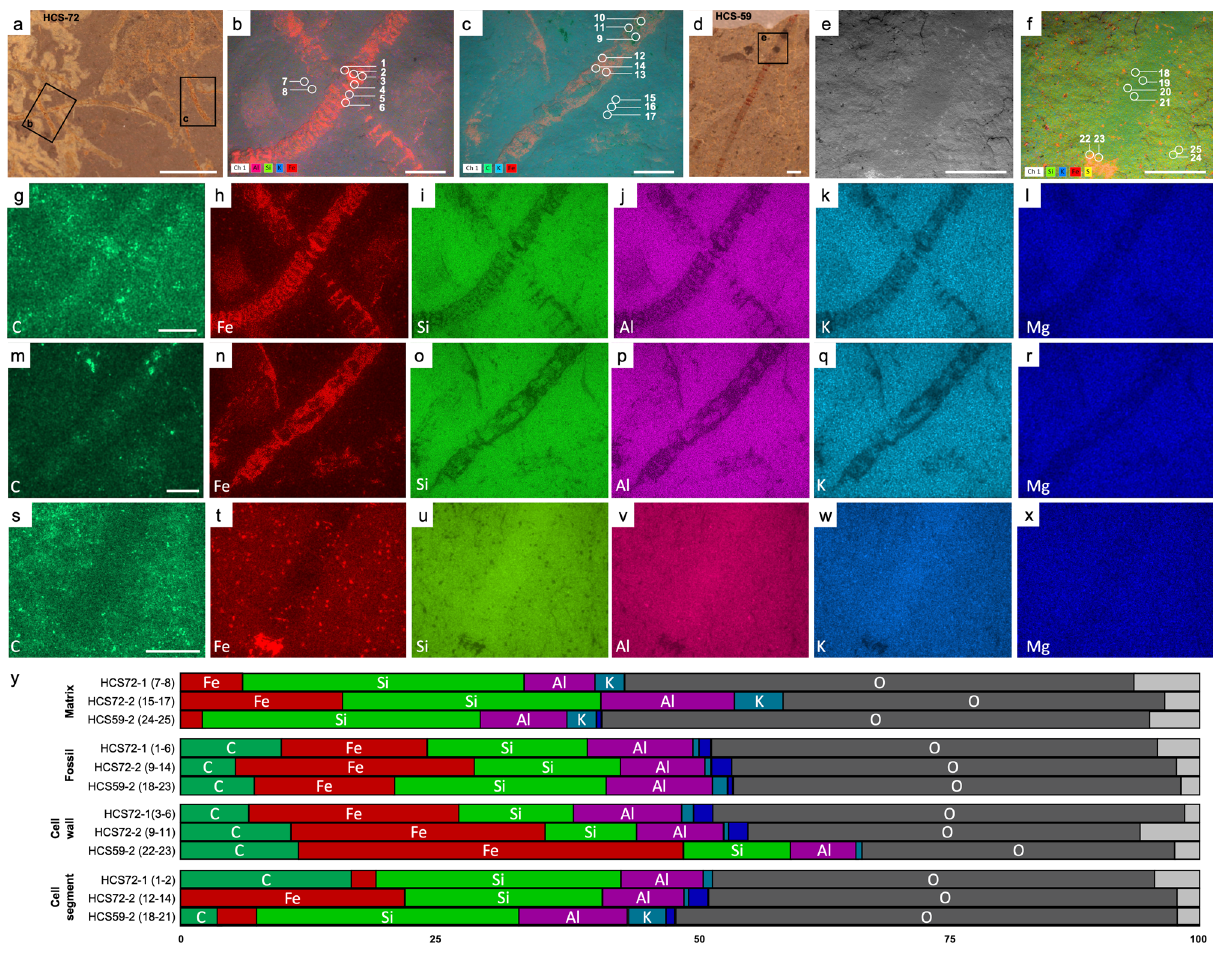
Figure 2. Grade 1: Well-preserved macroalgae. ( a ) Reflected light image of a well-preserved specimen (HCS- 72). ( b ) SEM BSE image with EDS overlay of HCS-72-1 ( a ) (rectangle) showing the locations of sampled point data and distribution of Al, Si, K, and Fe. ( c ) SEM BSE image with EDS overlay of HCS-72-2 ( a ) (rectangle) showing the locations of sampled point data and distribution of C, K, and Fe. ( d ) Reflected light image of HCS-59. ( e ) SEM BSE image of ( d ) (rectangle). ( f ) BSE image with EDS overlay of ( d ) showing locations of sampled point data and distribution of Si, K, Fe, and S. ( g – l ) EDS elemental maps for specimen HCS-72-1. ( m – r ) EDS elemental maps for specimen HCS-72-2. ( s – x ) EDS elemental maps for specimen HCS-59-2. ( y ) Bar plot illustrating the concentration of each element reported as the mean relative intensity in normalized weight percent from EDS point data where Dark Blue = Mg; Light Grey = remaining elements. White scale bar = 1 mm. EM images in this figure and Figs. 3, 4 were captured using the Zeiss SmartSEM software interface, and elemental maps were collected using Bruker Esprit 2 software. All figures were assembled using Adobe